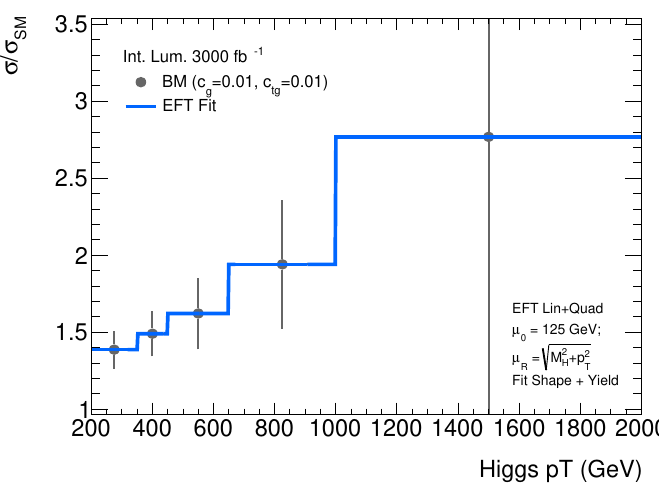
Figure 1. Example of an EFT fit on a benchmark p H spectrum (pseudo data) with the binning T adopted by the experiments. The R i deviations from the SM values for the ( c g ( M H ) = 0.01, c tg ( M H ) = 0.01, c t ( M H ) = 1.0) benchmark spectrum are given by the points with the estimated bin-by-bin uncertainties, which are obtained by combining the predicted ATLAS and CMS accuracies with 12% uncertainty on the SM cross section, while the continuous line shows the result of the EFT